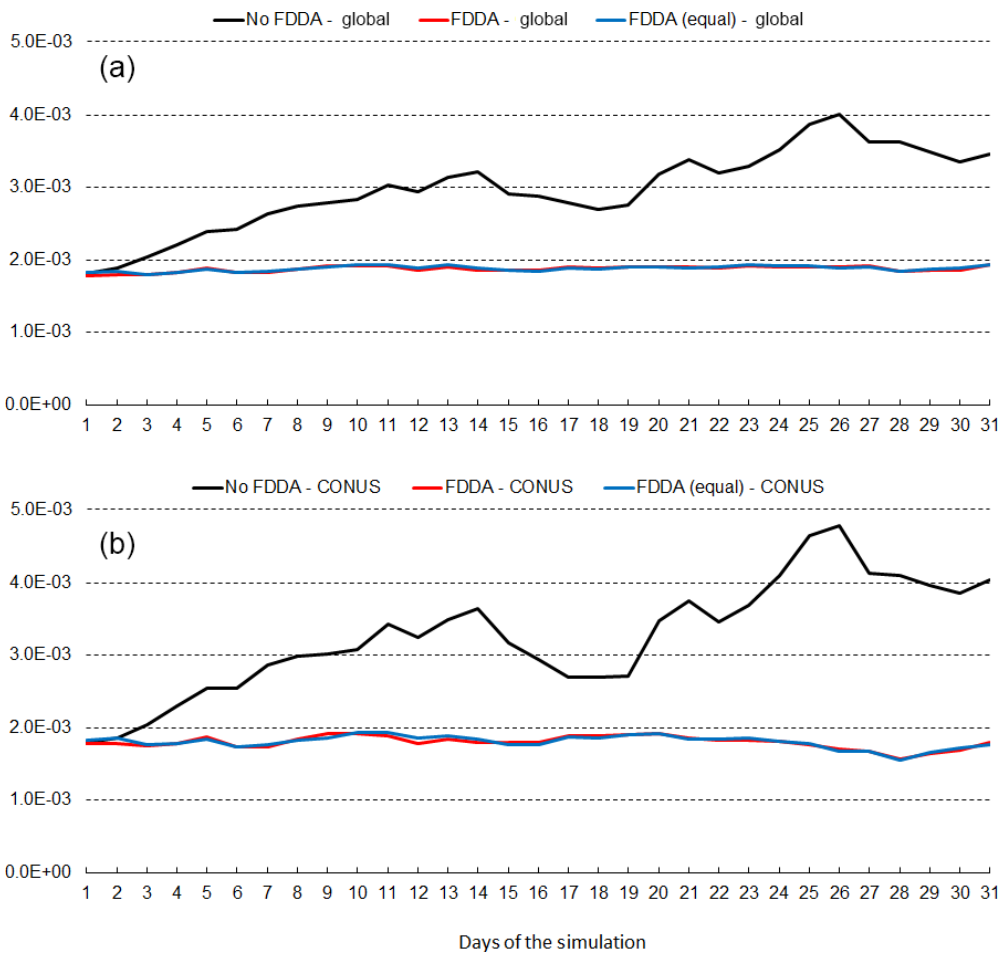
Figure 15. July 2013 time series plots of 2m water vapor mixing ratio ( q v ) RMSE for MPAS-A without FDDA (black line), MPAS-A with FDDA applied using weaker q v nudging (red line), and MPAS-A with FDDA applied at equal strength for all variables (blue line). Panel (a) shows results for the entire global domain, while (b) shows results for the CONUS